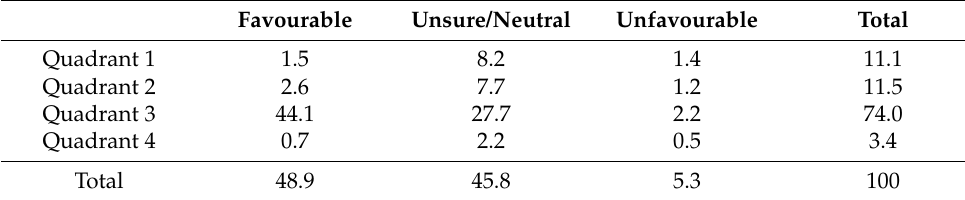
Table 9. I 3 classification and attitudes towards trapping possums 1